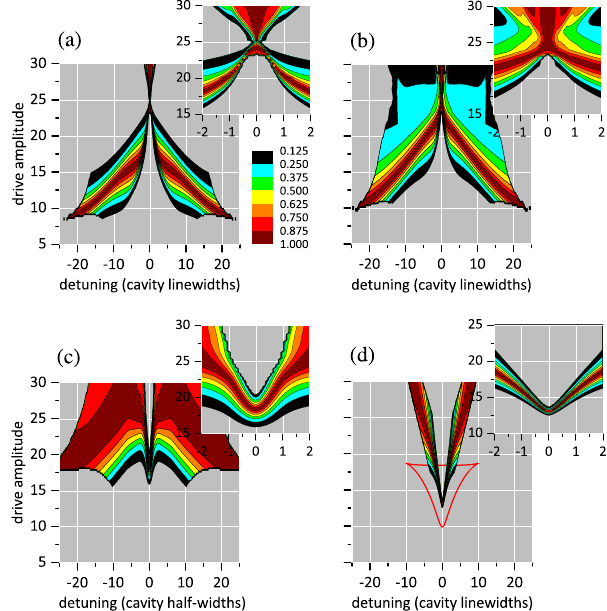
FIG. 8. As in Fig. 2 with spontaneous emission at the rate lines in (d) outline the bistable region according to the state equation [Eq.